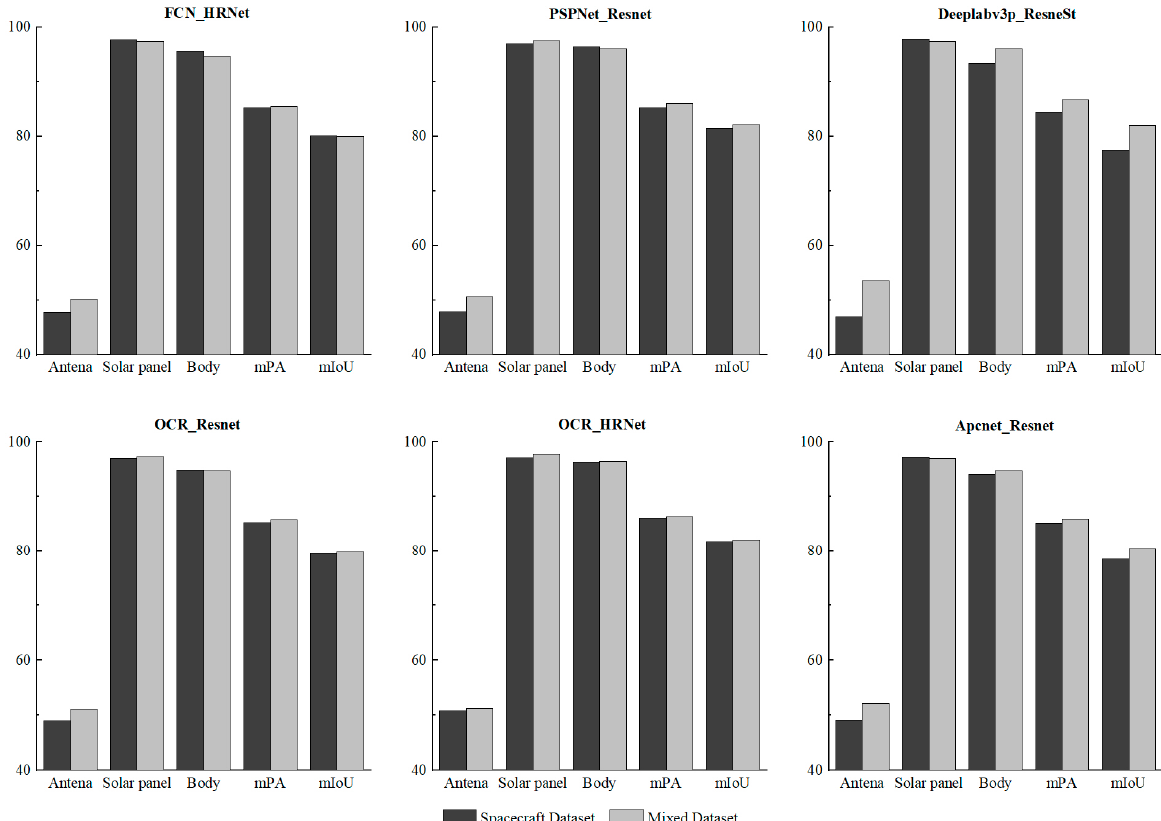
Figure 16. Comparison of the validation accuracy between the mixed dataset and the spacecraft dataset training results in the real-shot validation dataset.